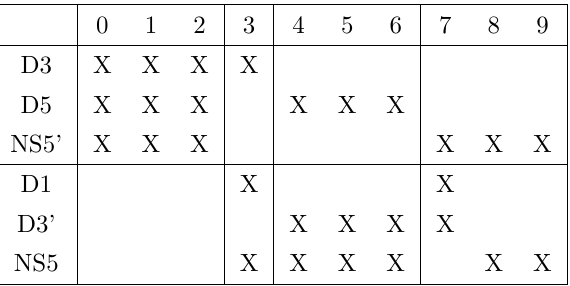
Table 1 . Brane array for 3d N = 4 theories and half-BPS local